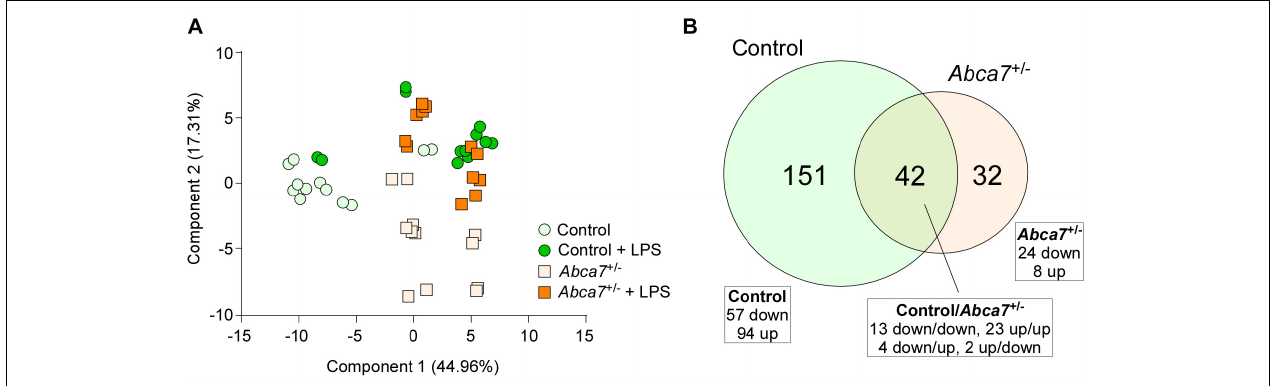
FIGURE 1 | Influence of ABCA7 haplodeficiency on LPS-induced metabolomic changes in mouse brains. Metabolomics was conducted in the cortex of control and Abca7 ± mice ( N = 6/each) administrated with or without LPS. (A) Principal component analysis (PCA) of metabolites from control and Abca7 ± mice with or without LPS administration. (B) Venn diagram of the metabolites differently induced by LPS administration in control and/or Abca7 ± mice.